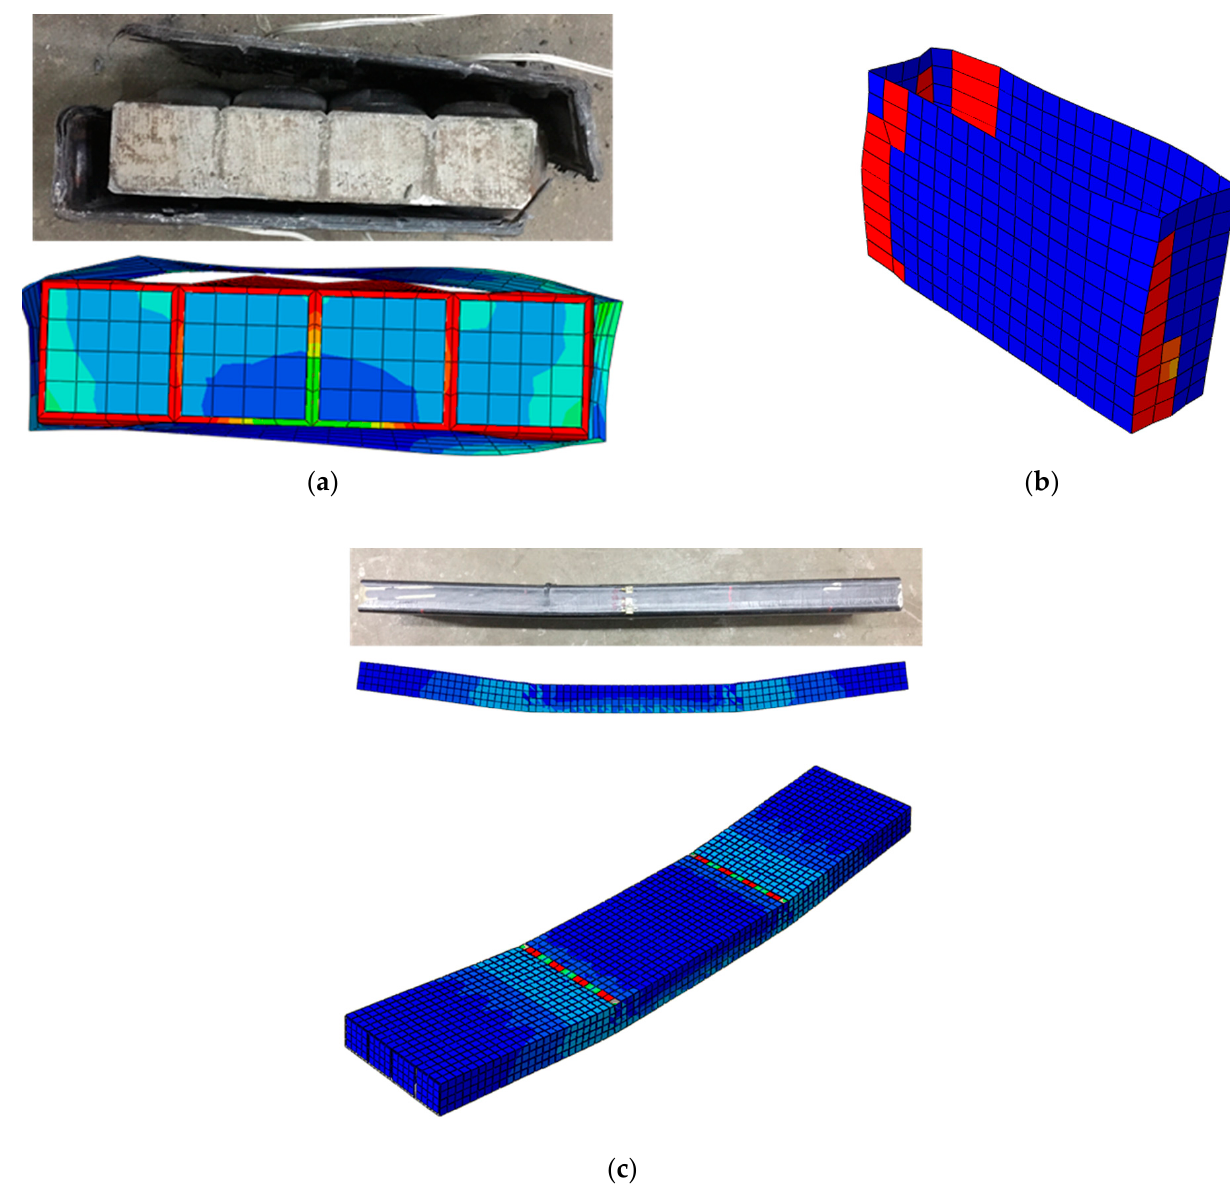
Figure 8. ( a ) FEA model of the compression test. ( b ) The damage to CFRP marked in red. ( c ) FEM model of the bending test.